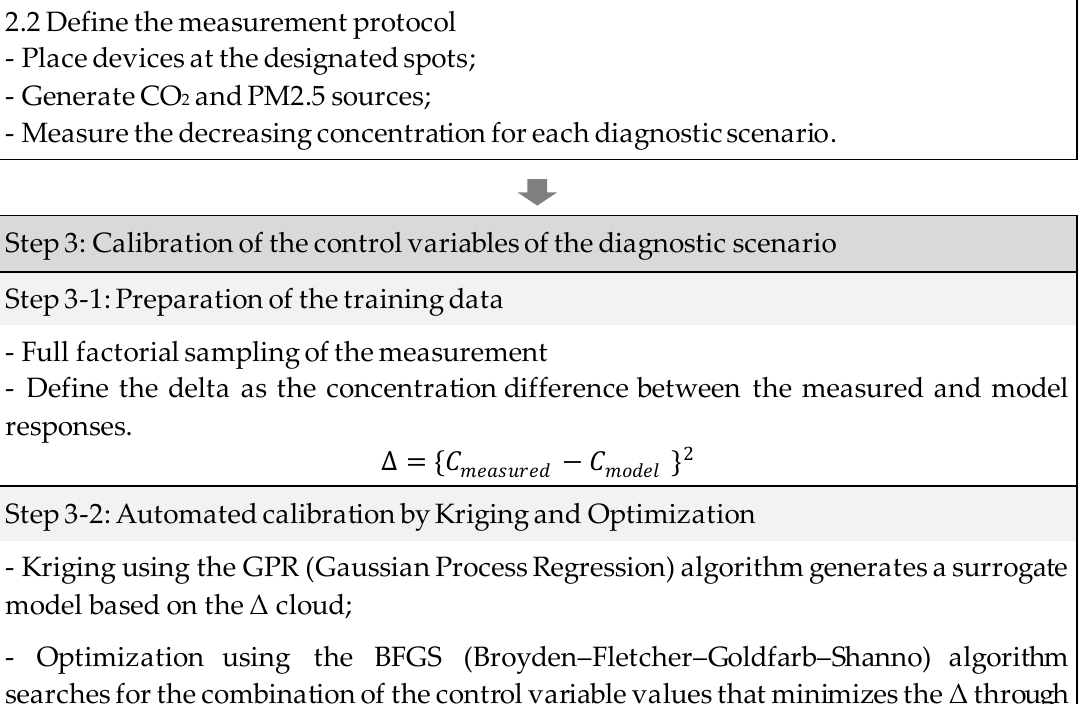
Figure 1. Steps for preparing an IAQ baseline for school retrofitting.